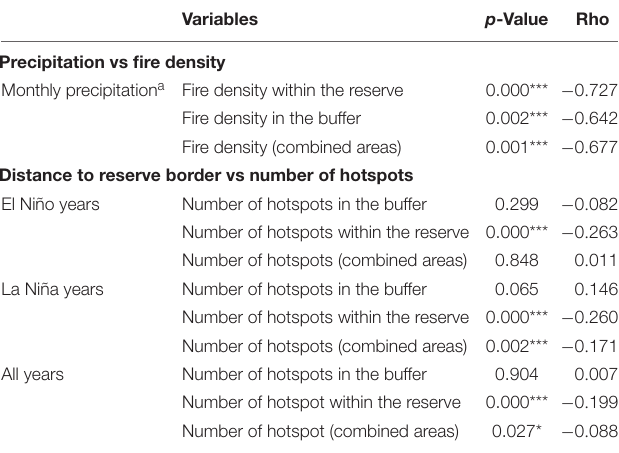
TABLE 3 | Spearman correlation between monthly precipitation during fire periods (August–October) of 2001–2020, distance from border and number of hotspots in the PSWR and surrounding areas of Sumatra,